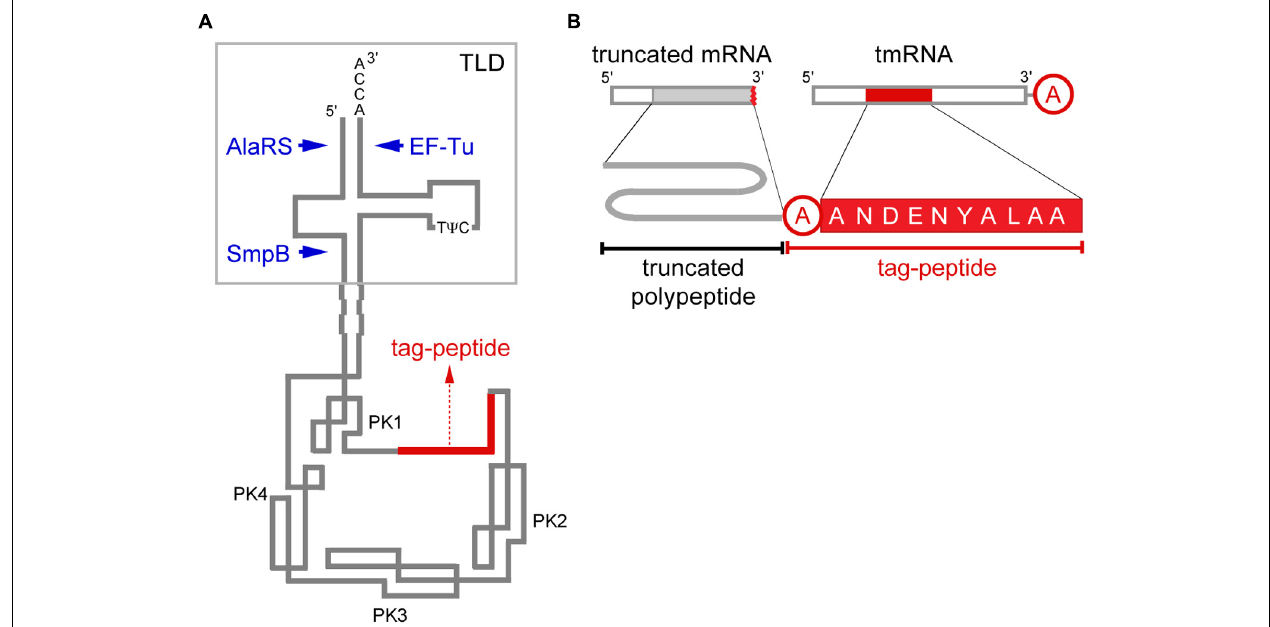
FIGURE 1 | tmRNA and trans -translation. (A) Secondary structure model of tmRNA.The 3 (cid:2) -end CCA sequence, amino acid acceptor stem, D-arm and T-arm with two typical tRNA-specific modified nucleotides, 5-methyluridine (T) and pseudouridine ( ψ ; Felden etal., 1998), are present inTLD of E. coli tmRNA to which alanyl-tRNA synthetase (AlaRS), EF-Tu and SmpB bind.The tag-encoding sequence (red) is surrounded by four pseudoknot structures